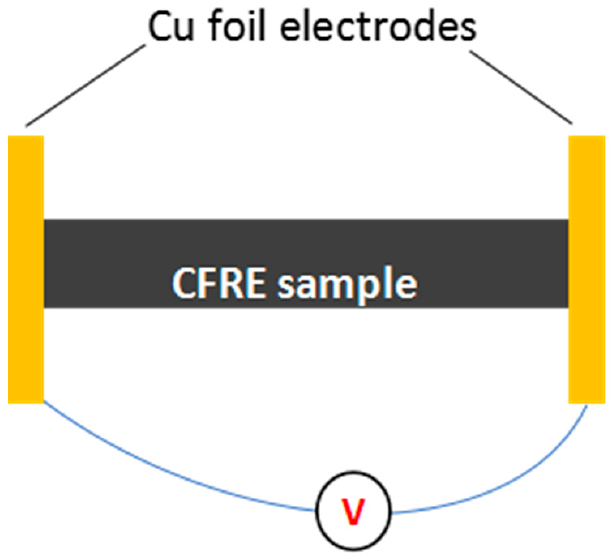
Figure 3. Wiring diagram for the electrothermal treatment of CFRE plate.